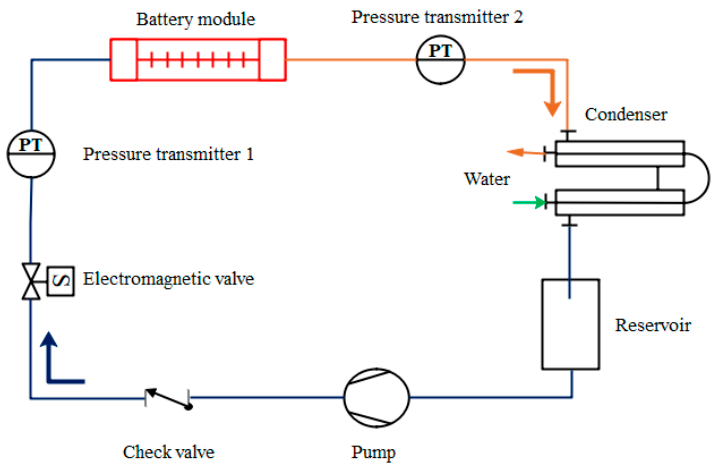
Figure 2. Schematic of the refrigerant circulating battery-cooling system.